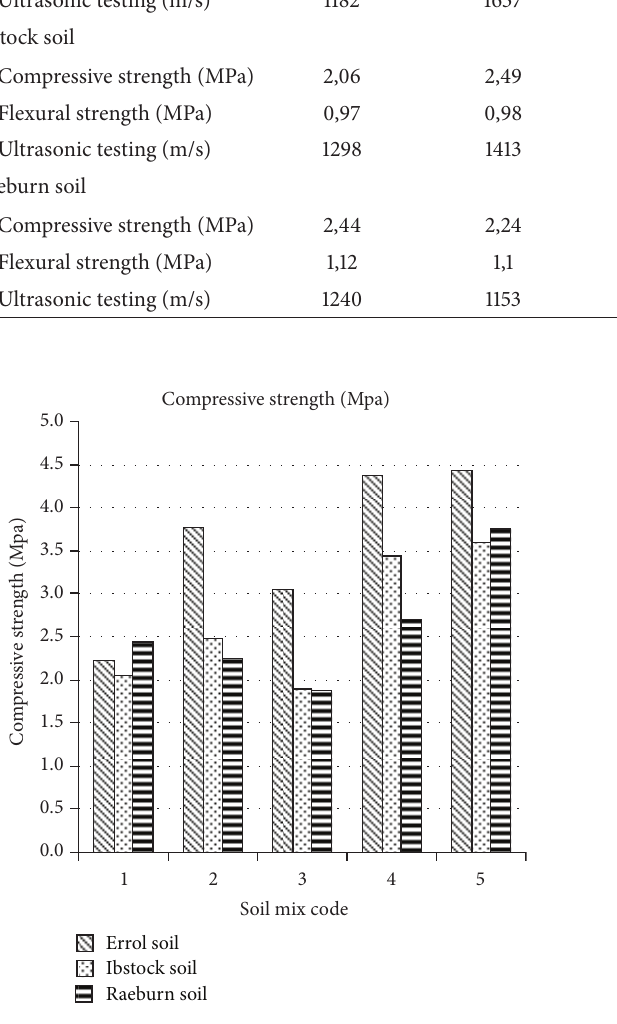
Figure 7: Graphical comparison of the compressive strength results on the five different mixes of the three types of soils.